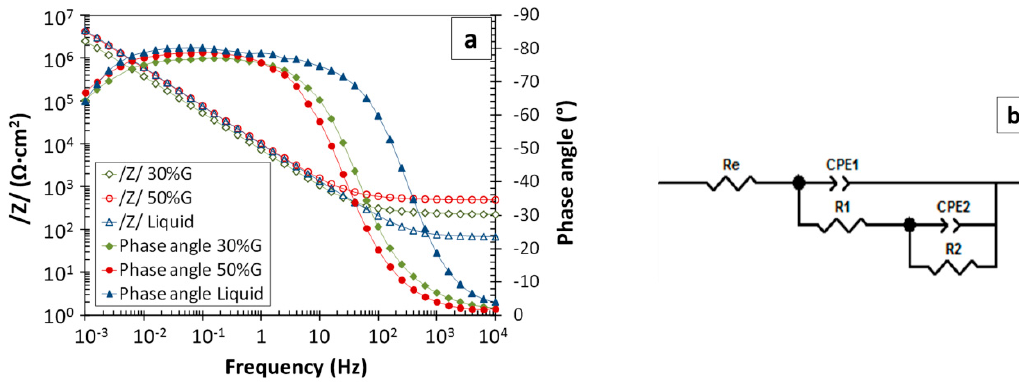
Figure 8. ( a ) Electrochemical impedance spectroscopy (EIS) spectra obtained for electrolytes with 0.5% NaCl, and ( b ) equivalent circuit generated by fitting the experimental spectra.